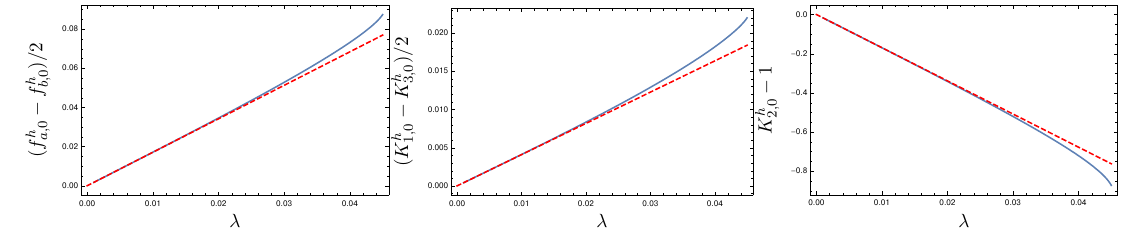
Figure 16 . Sample of the IR parameters of linearized approximations in λ are represented by dashed red